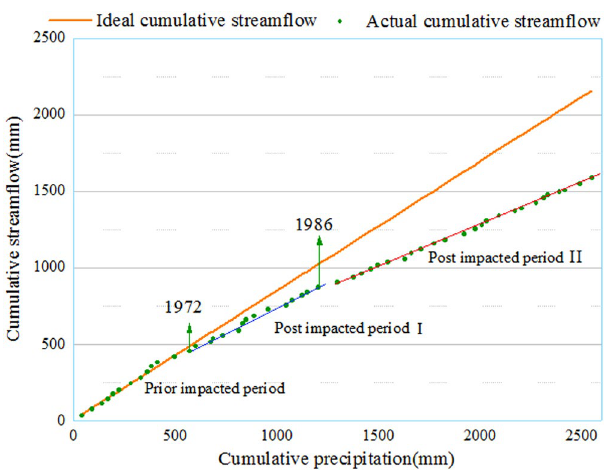
Figure 3. The plot of cumulative precipitation versus cumulative streamflow with the Double mass curve analysis of the Tarim River during 1960 to